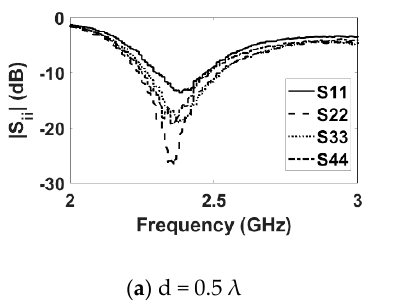
Figure 5. Measured reflection coefficient (E plane).